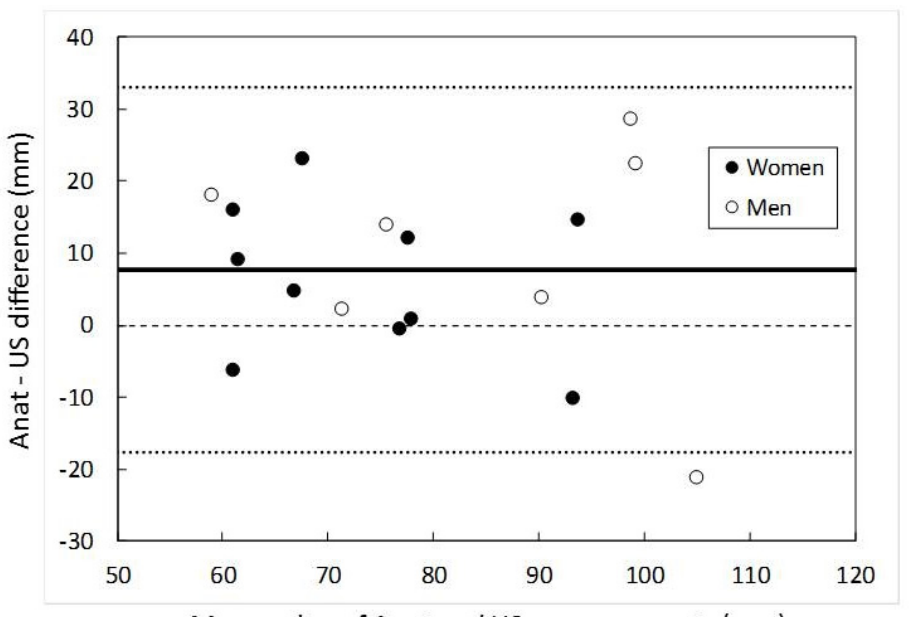
Figure 9. Bland–Altmann graphs for the distances from lateral epicondyle to the hiatus point where the posterior antebrachial cutaneous nerve (PACN) pierces the deep fascia. The Y-axis represents the difference in the measurements taken by anatomical dissection and US imaging. The X-axis represents the mean value of the measurements obtained by the two methods. The horizontal solid line represents the bias, whereas the dotted lines are the upper and lower limits of agreement (LOA), calculated as 1.96 SD (standard deviation). A dashed line indicates zero difference (equality).